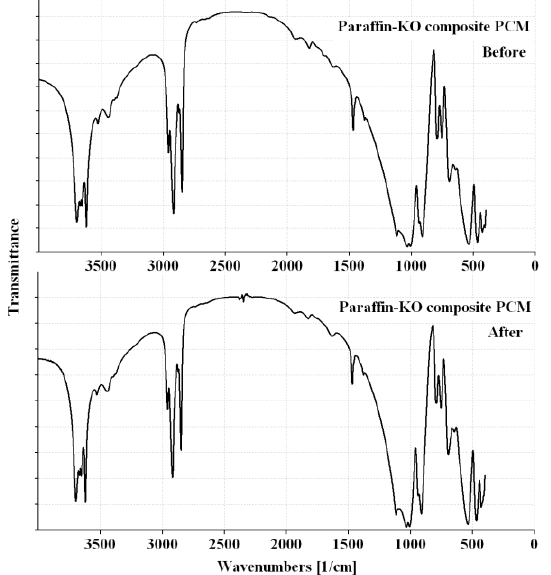
Figure 8. FT-IR spectra of Paraffin-Kaolin composite PCM before and after thermal cycling.